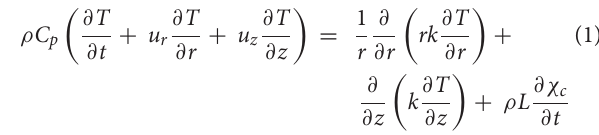
Frontiers in Earth Science |